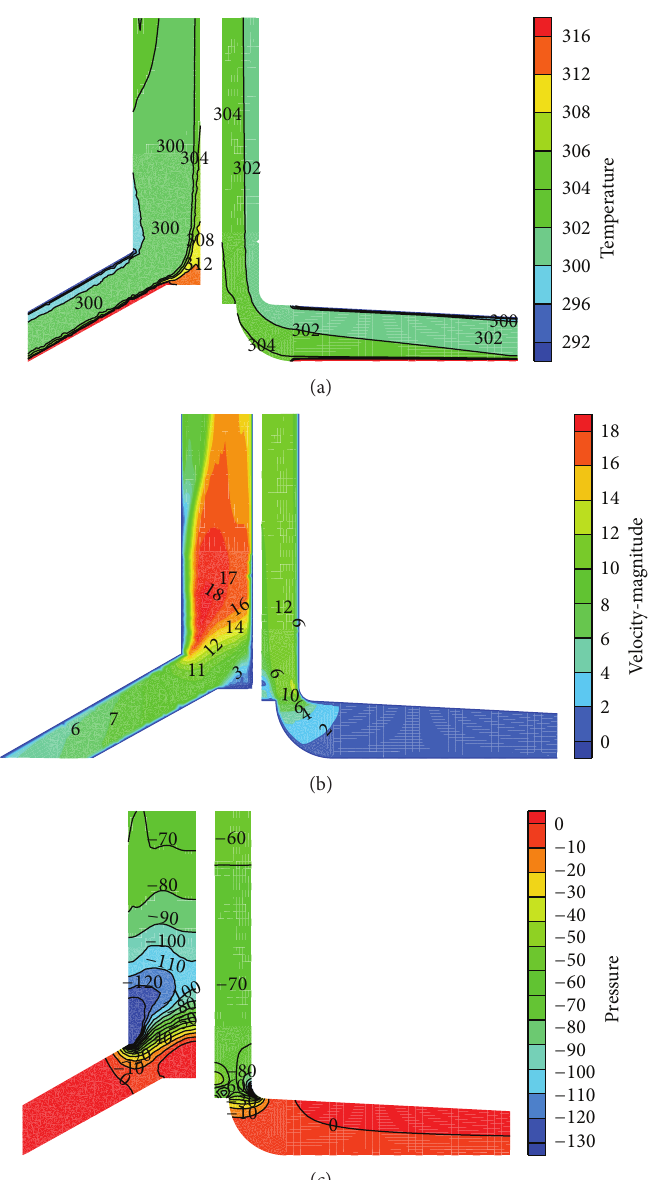
Figure 7: Comparison of the CSCPP and the SSCPP inner detail performance (temperature unit: K, velocity unit: m/s, and pressure unit: Pa).